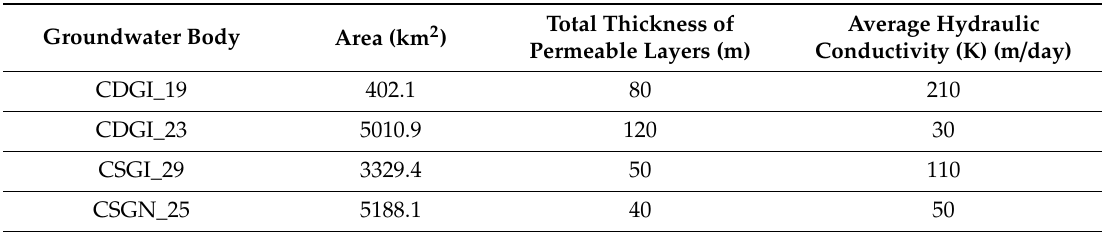
Table 1. Groundwater body characteristics. Thickness and hydraulic conductivity data refer to gravel and sand aquifers in groundwater bodies.